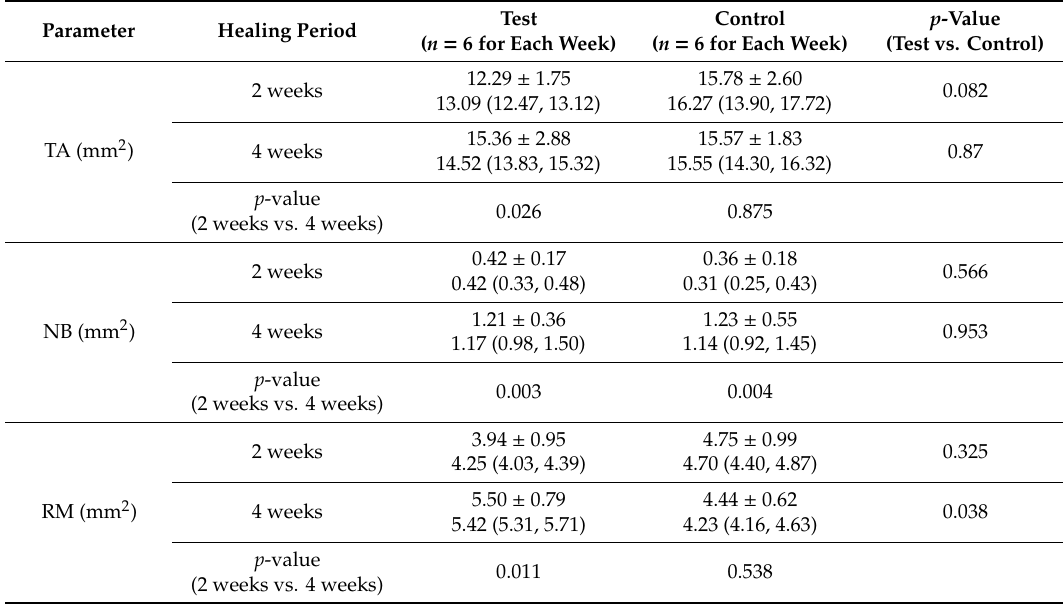
Table 1. Histomorphometric analyses in the test and control